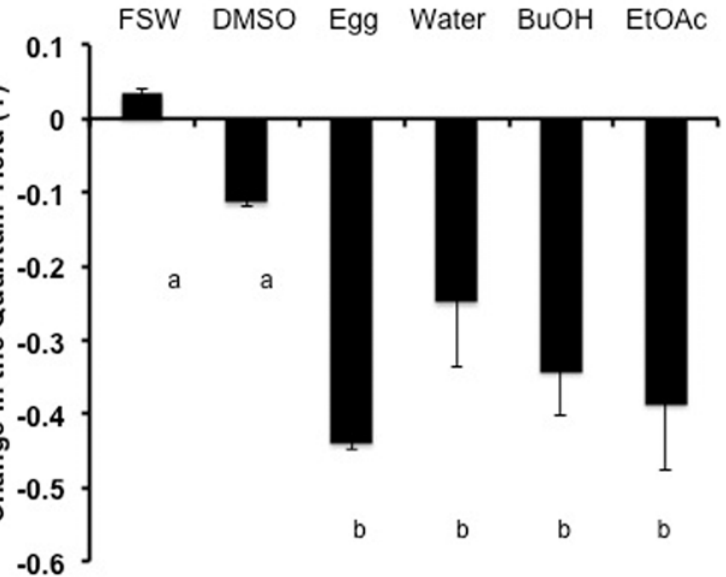
Fig 7. The reduction in the quantum yield of F . scutaria zooxanthellae due to M . capitata egg chemical fractions. The zooxanthellae from two individuals were divided up into 5 sub-samples and exposed to 30 µ l of FSW, dimethyl sulfoxide (DMSO), frozen crushed M . capitata eggs, water fraction, butanol fraction (BuOH) or ethyl acetate fraction (EtOAc). The quantum yield of FSW and DMSO, were not different (P > 0.05, ANOVA, Dunnett ’ s Multiple Comparison Test). But adding 30 µ l of each of the chemical fractions or frozen eggs caused a reduction of 25 to 44% in the quantum yield over 40 min over the FSW values (P > 0.05, ANOVA, Dunnett ’ s Multiple Comparison Test). Bars with different letters were (P < 0.05). Bars indicate